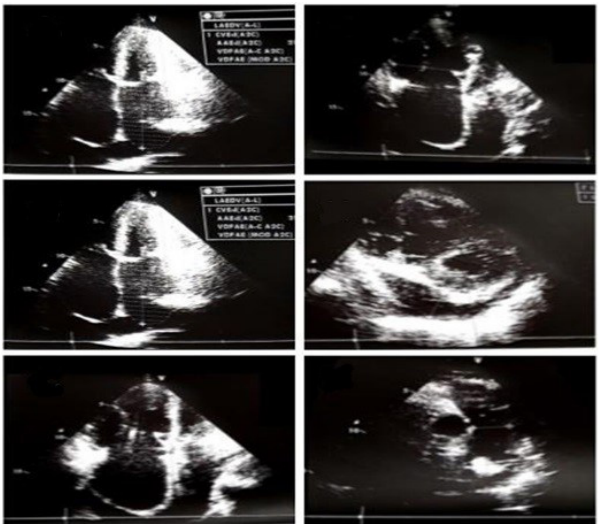
Fig. 2 - Transthoracic echocardiogram demonstrating an opening in the dome of the mitral valve with significant mitral stenosis, biatrial and right ventricular enlargements, moderate/significant tricuspid insufficiency, mild pulmonary arterial hypertension and pericardial